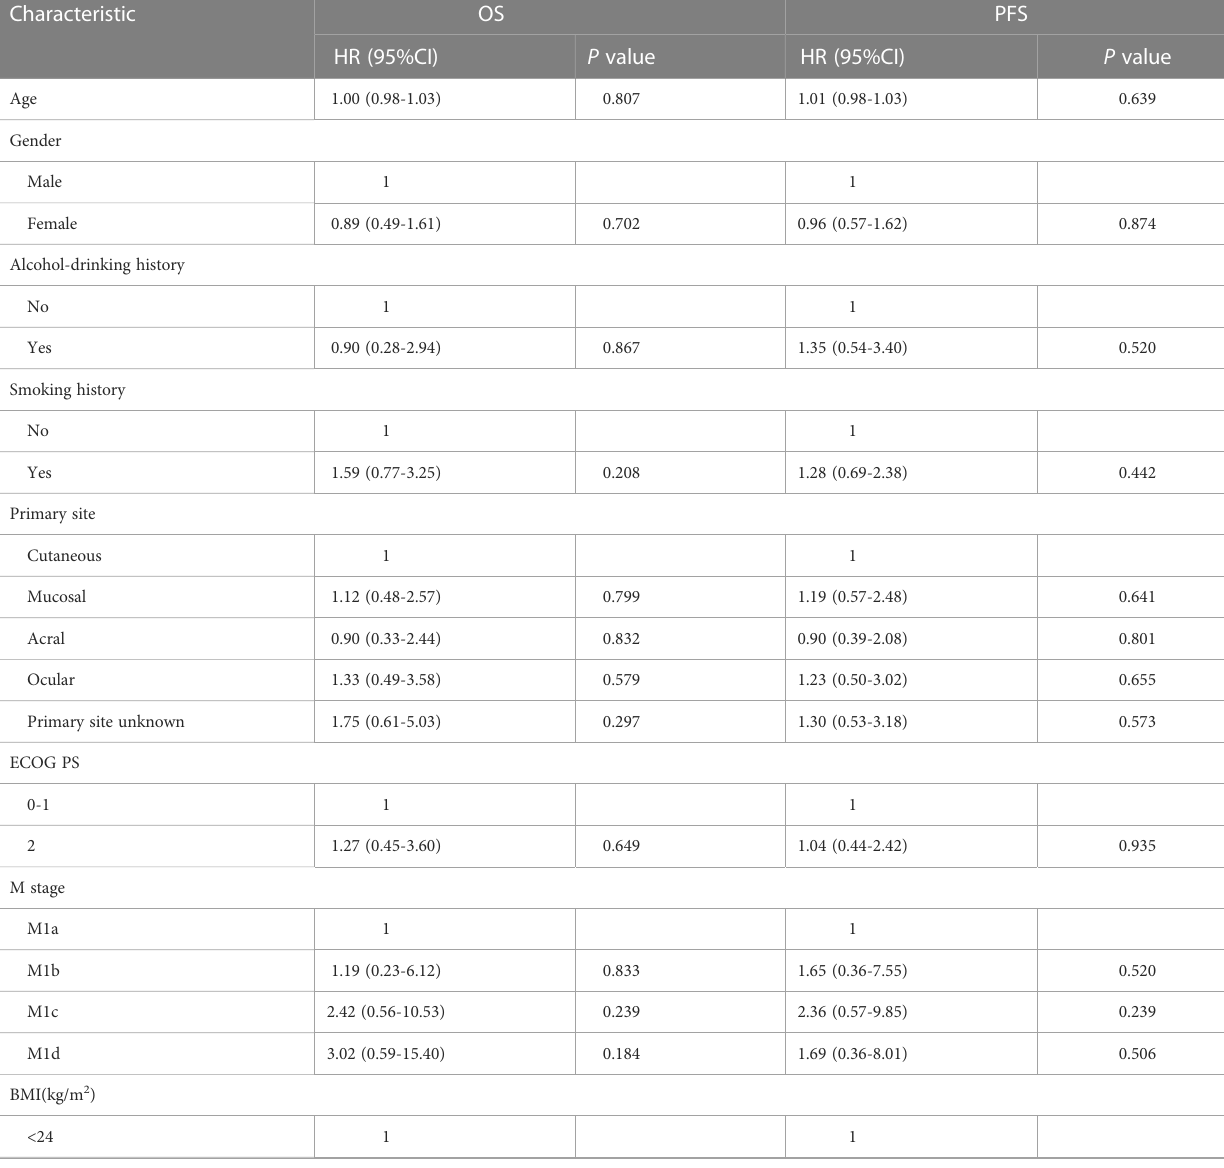
TABLE 2 Univariate Cox regression model on overall survival and progression-free